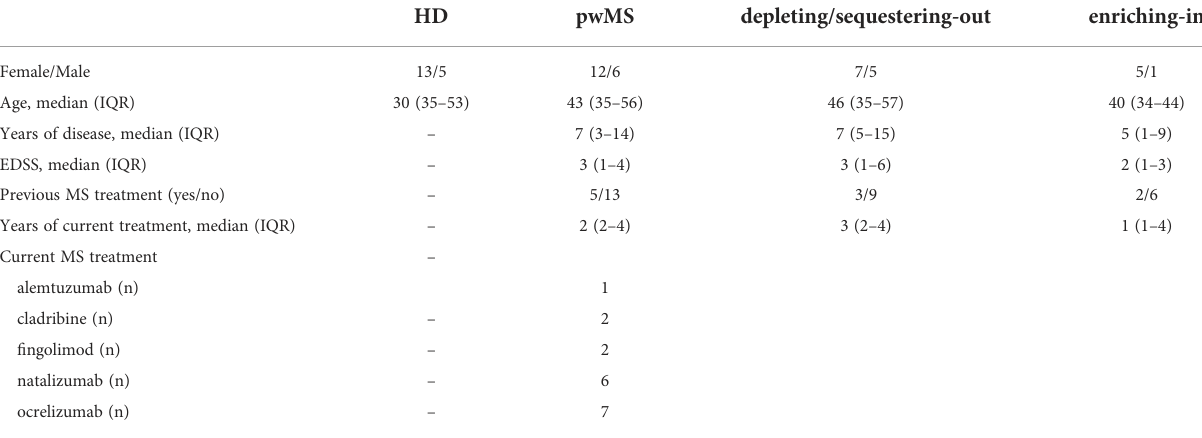
TABLE 1 Demographic and clinical features of study population.